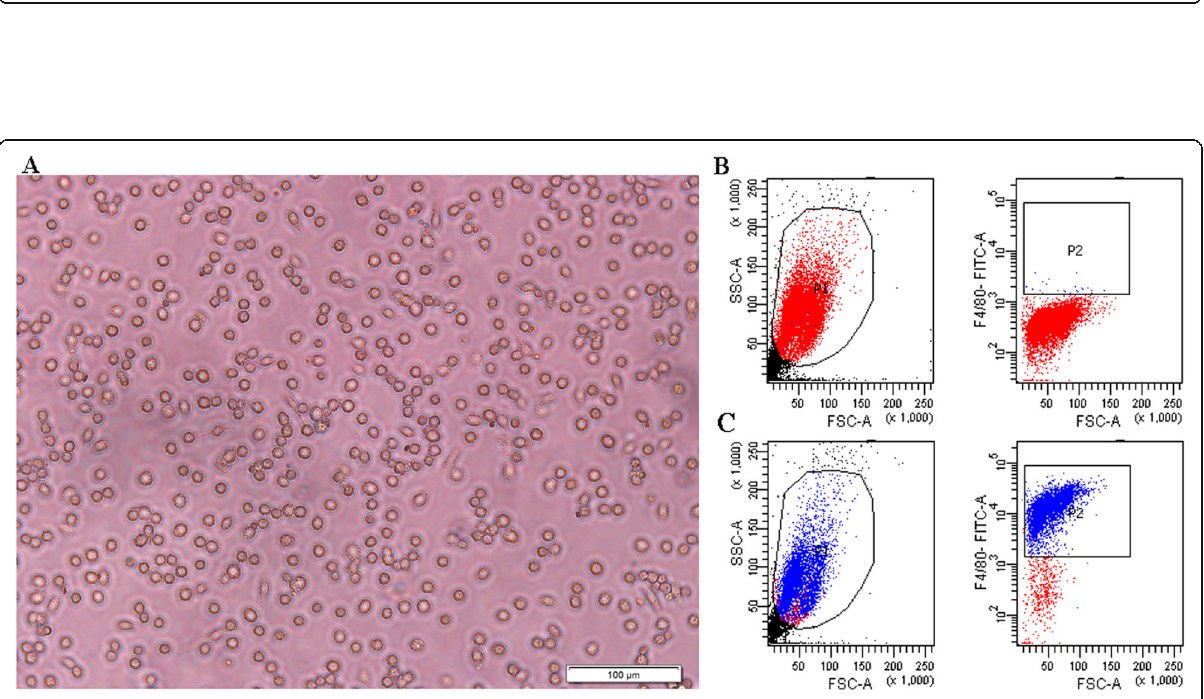
Fig. 2 Peritoneal macrophage morphology ( a ) and proportion identification ( b - c ). b Negative controls without antibodies. c Macrophages labelled by